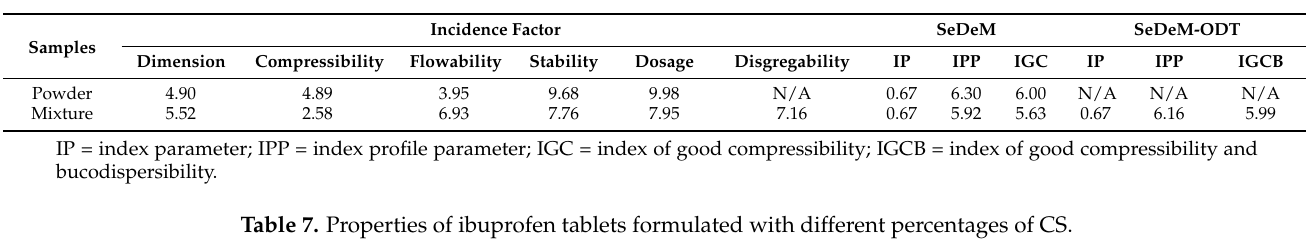
Table 6. Incidence factor and parametric index values of the ibuprofen powder and mixture.